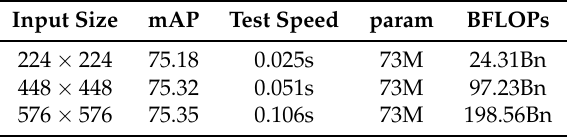
Table 9. Performance testing of our U-Field-Net (including post process time) on DOTA. All the speed are tested on a single RTX